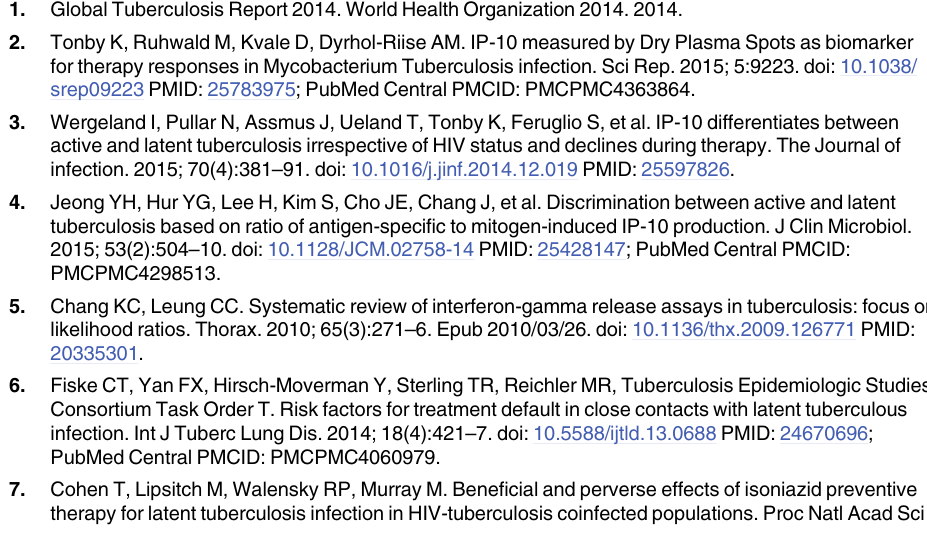
S1 Fig. Top four cytokines in Nil supernatants of patients with active TB, LTBI and healthy controls. S2 Fig. Top four ROC curves comparing the diagnostic accuracy of cytokines in Nil super- natants for differentiating active TB from LTBI. S1 Table. Concentrations of cytokines in the three groups (Nil). S2 Table. AUCs for discriminating active tuberculosis from LTBI (Nil). S3 Table. Correlations between concentrations of cytokines and clinical findings